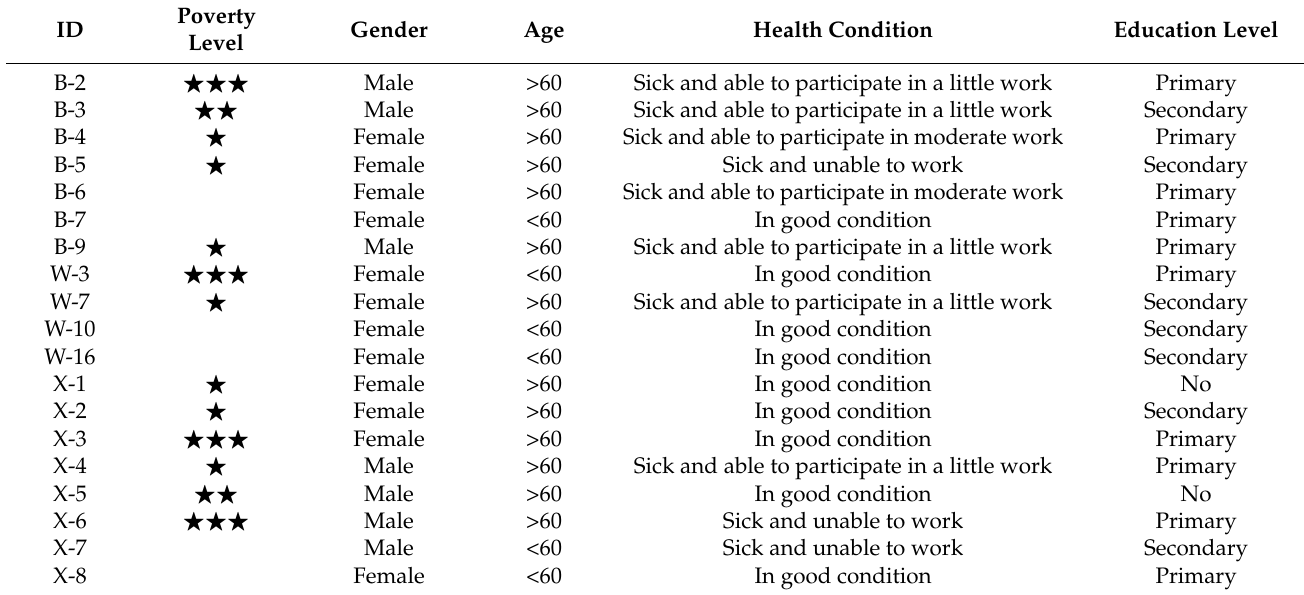
Table 2. Basic information of